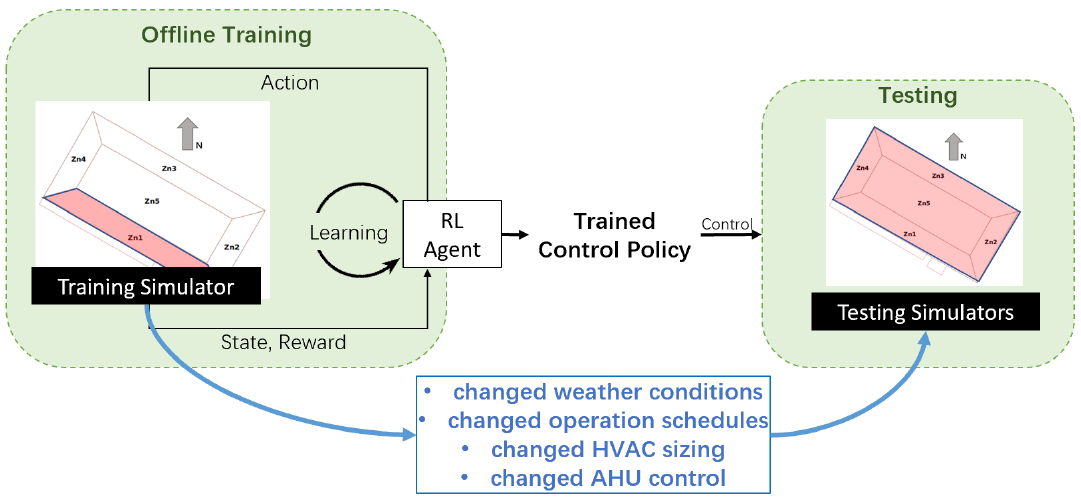
Figure 2. The schematic workflow of reinforcement learning control in this study.